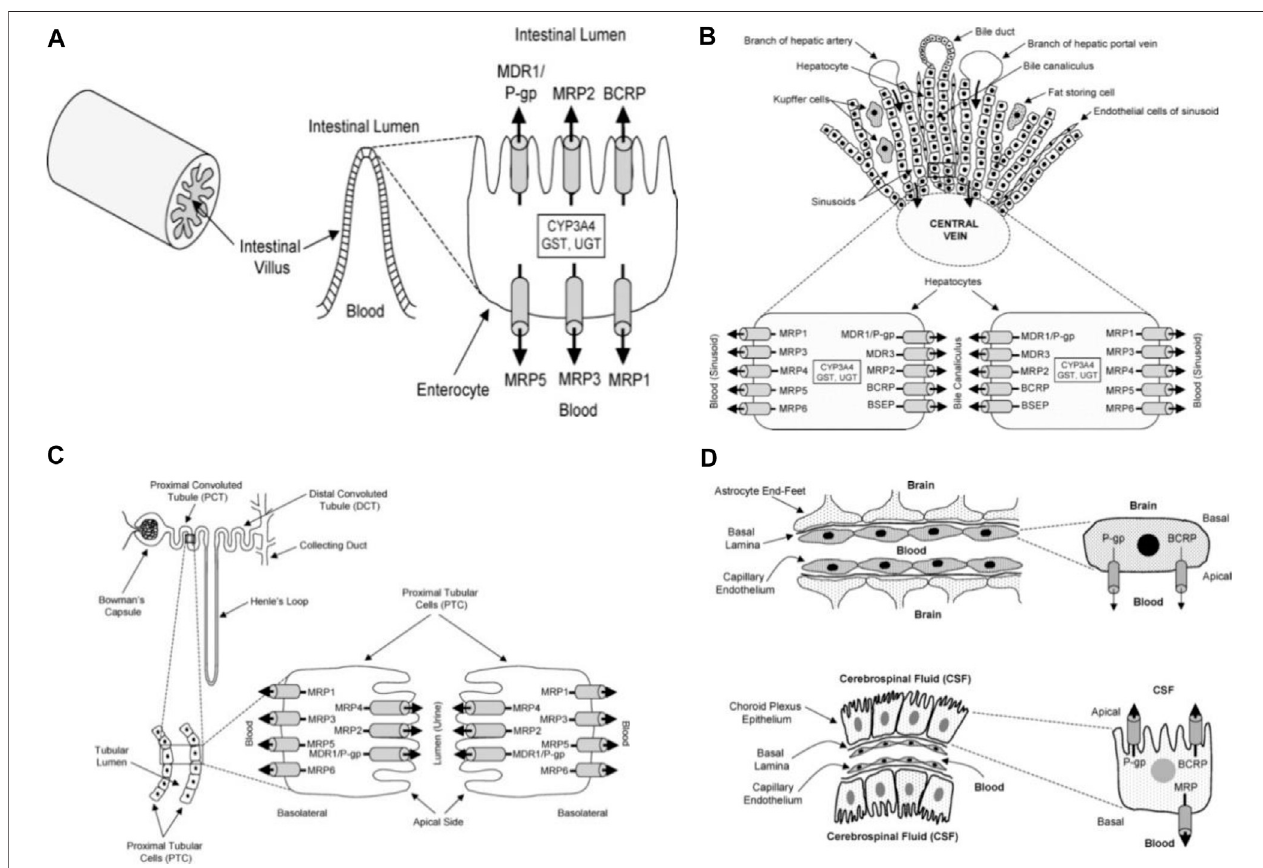
FIGURE 5 | Diagrammatic section of the small intestine (A) , liver (B) , proximal tubular cells of kidney (C) , choroid plexus epithelium and blood brain barrier (D) adapted from Choudhuri and Klaassen